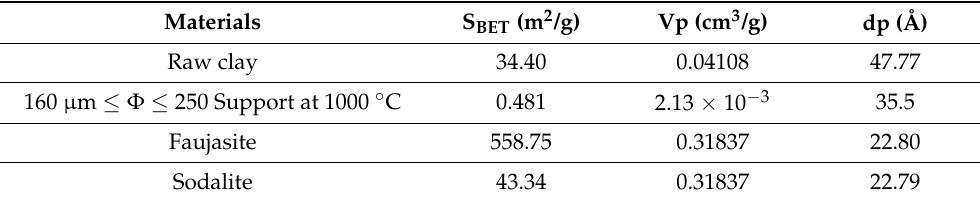
Table 3. Structural parameters of adsorption/desorption isotherms of N 2 on Raw Clay, FAM, and SOM clay/zeolite composite